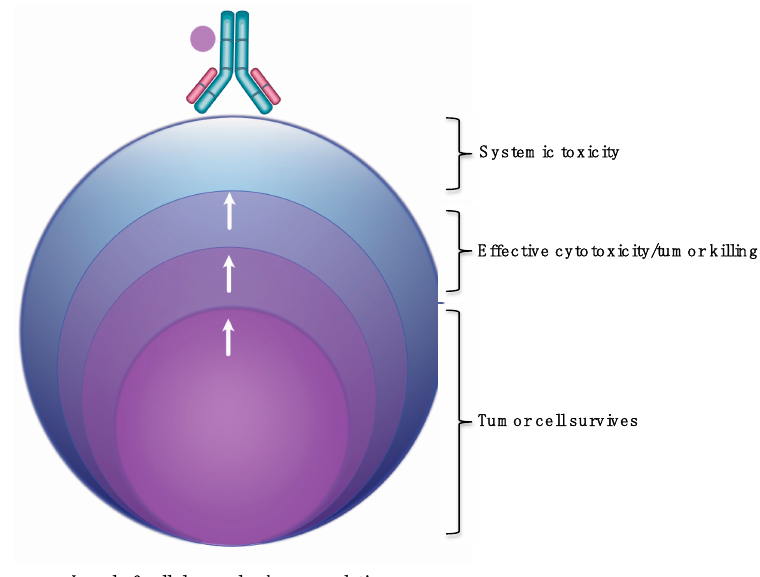
Figure 3. The working ‘goldilocks’ model of the required amount of cellular accumulation of anti-HER2 ADC-delivered payloads to evoke effective tumor killing. Too much drug accumulation causes systemic toxicity. Too few drugs accumulated results in tumor cell survival. An effective amount accumulates the drug at just the right concentration.